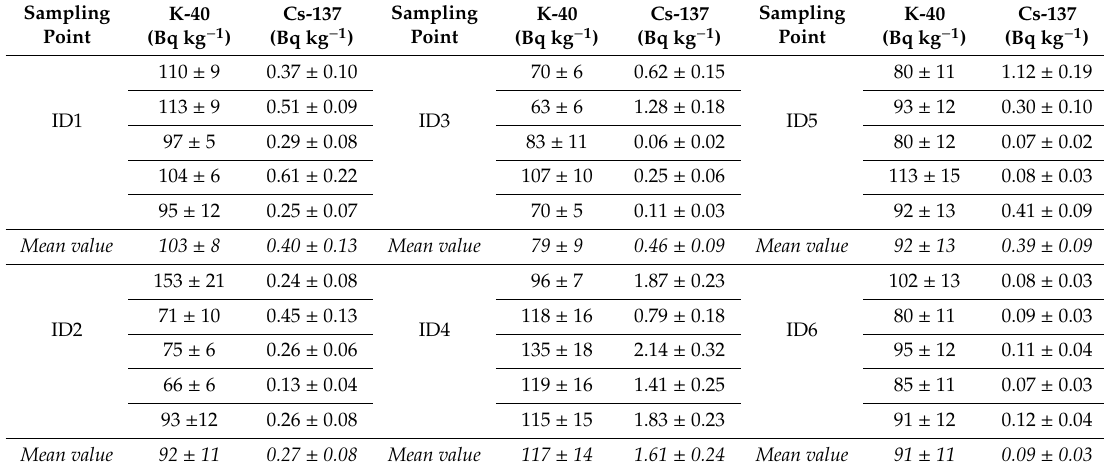
Table 2. The activity concentration of 40 K and 137 Cs for the analyzed wild boar meat